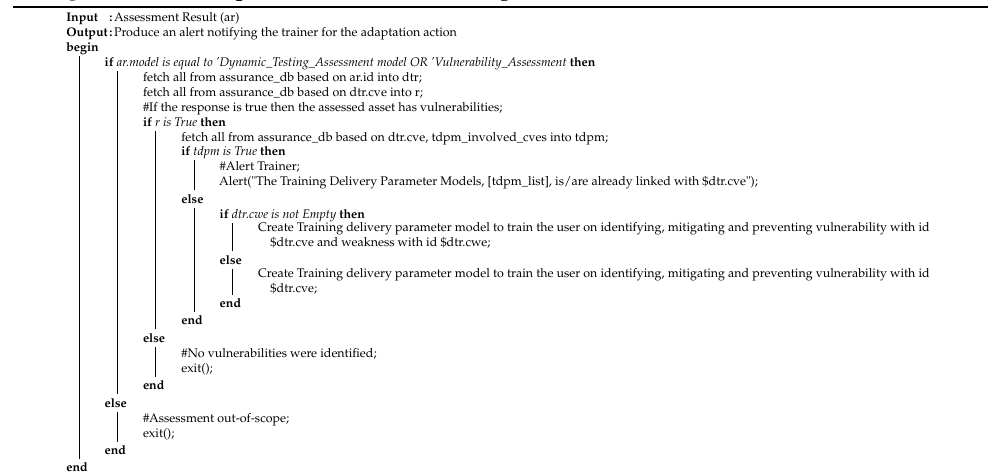
Algorithm 2: Adaptation based on existing asset